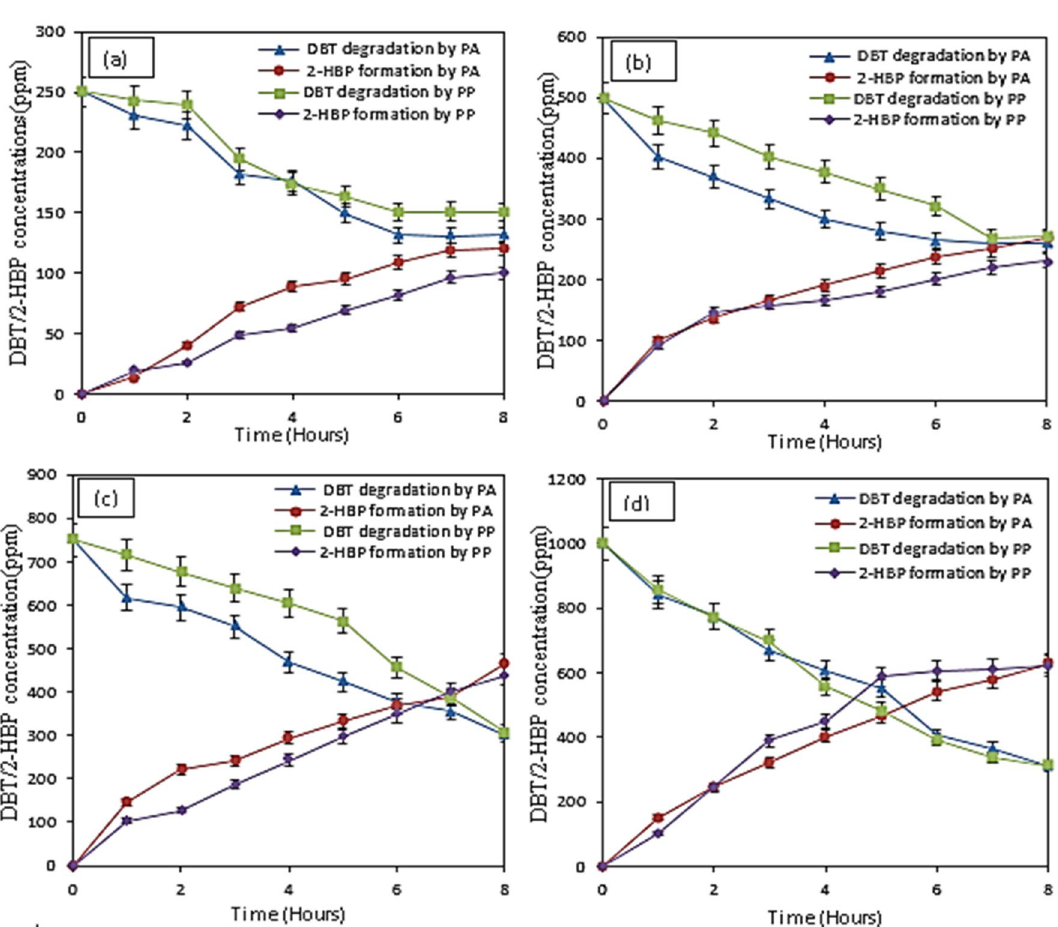
Figure 6. Effect of initial DBT concentration on DBT degradation by Pseudomonas aeruginosa and Pseudomonas putida ( a ) 250 ppm, ( b ) 500 ppm ( c ) 750 ppm ( d ) 1000 ppm. Experimental conditions: Cell concentration 1.2 g DCW/L, Temperature 37 °C (Pseudomonas aeruginosa), 30 °C (Pseudomonas putida), Shaking speed 130